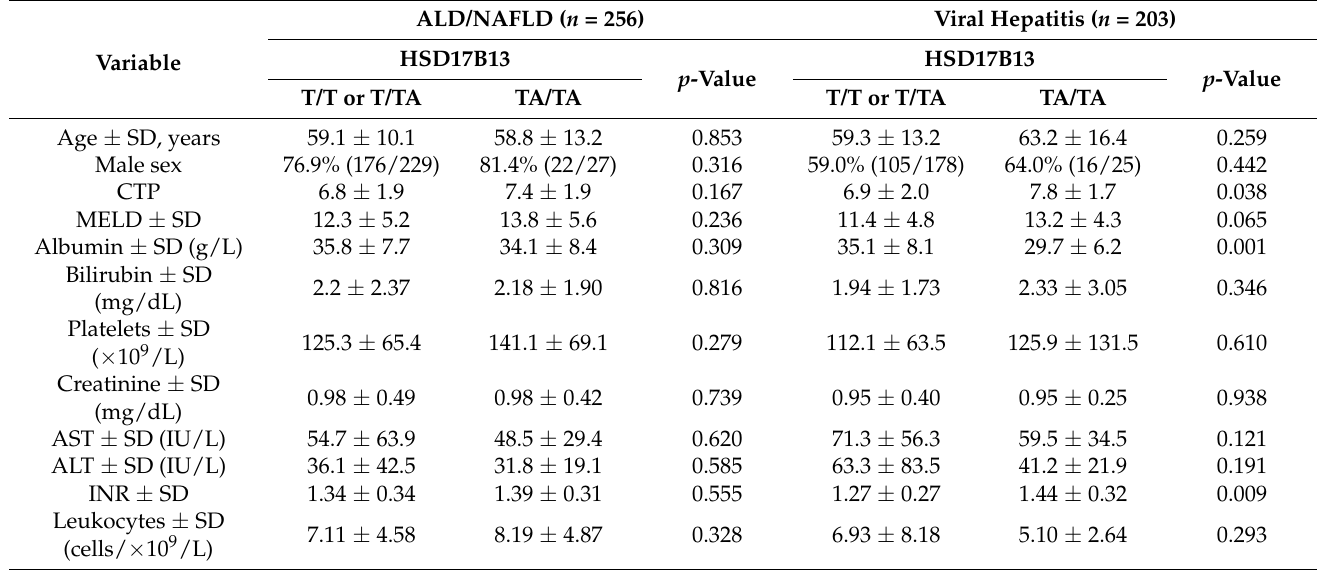
Table 3. Comparison of patients’ characteristics according to the genotype of HSD17B13 , depending on the etiology of the